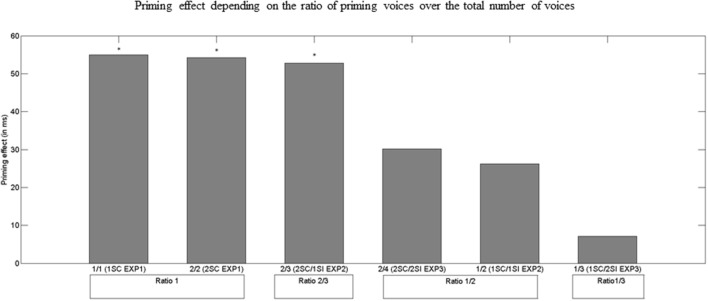
Semantic priming effect (i.e., difference between RTs for unrelated and related targets; in ms) depending on the ratio of SC voices in the background over the total number of voices. 1SC EXP1, 1SC condition in Experiment 1 (1 SC voice; no SI voice); 2SC EXP1, 2SC condition in Experiment 1 (2 SC voices; no SI voice); 2SC/1SI EXP2, 2SC/1SI condition in Experiment 2 (2 SC voices; 1 SI voice); 1SC/1SI EXP2, 1SC/1SI condition in Experiment 2 (1 SC voice; 1 SI voice); and 2SC/2SI EXP3, 2SC/2SI condition in Experiment 3 (2 SC voices; 2 SI voices); 1SC/2SI EXP3, 1SC/2SI condition in Experiment 3 (1 SC voice; 2 SI voices).